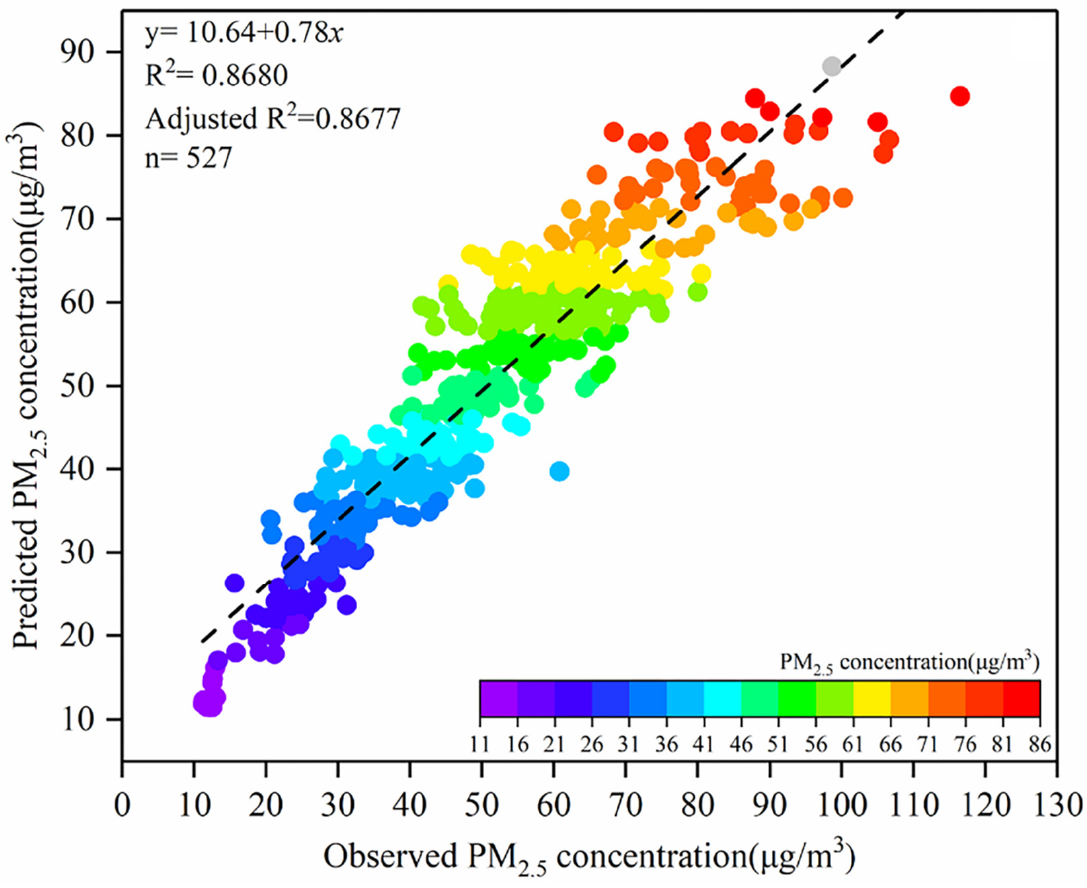
Figure A3. The predicted and observed PM 2.5 concentration.